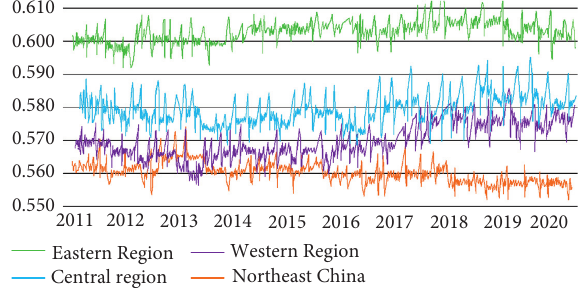
Figure 6: Change trend of Moran value in